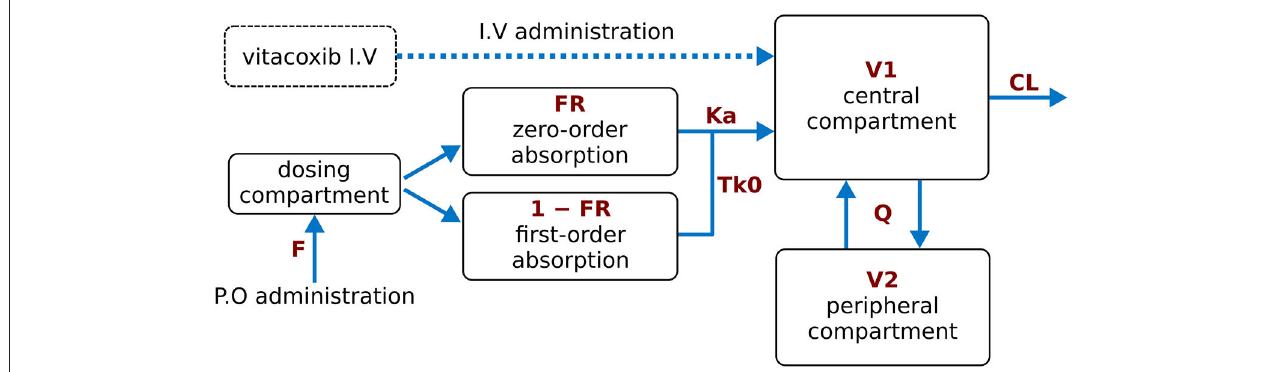
FIGURE 1 | Final model structure of vitacoxib pharmacokinetics following I.V and P.O dosing in healthy cats. A two-compartment pharmacokinetic model, with mixed first-order and zero-order absorption for the P.O route, best described the pharmacokinetics of vitacoxib in plasma. CL: vitacoxib systemic clearance;